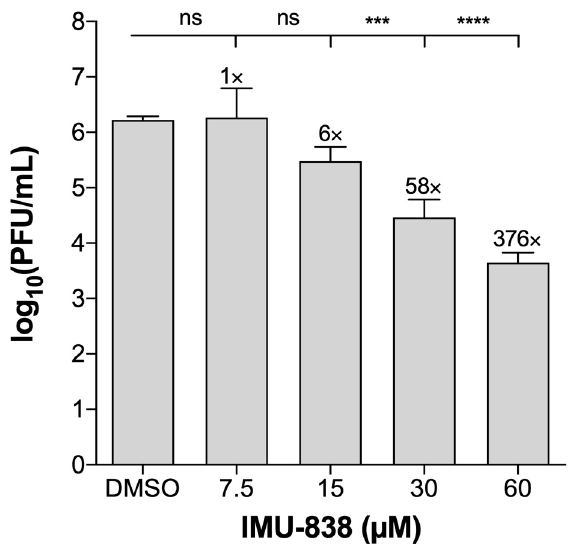
Figure 4. Determination of anti-SARS-CoV-2 activity of IMU-838 in CaCo-2 cells. CaCo-2 cells were infected with SARS-CoV-2 at an MOI of 0.001 for 1.5 h at room temperature. Thereafter, fresh medium containing DMSO or IMU-838 (7.5, 15, 30 or 60 µM) was added. At 72 h p.i., supernatants were collected, and serial dilutions of the supernatants were incubated on a monolayer of Vero E6 cells. After 1.5 h, medium was removed, and cells were incubated for 72 h with fresh medium at 37 °C. After this incubation, cells were fixed and stained with crystal violet, and plaque formation was determined. The test was performed in triplicate ( n = 3), and absolute values of plaque-forming units (PFU) are given (mean ± SD). Statistical significance is indicated according to one-way ANOVA followed by Tukey’s multiple comparison test: *** p <0.001; **** p <0.0001; n.s., not significant.